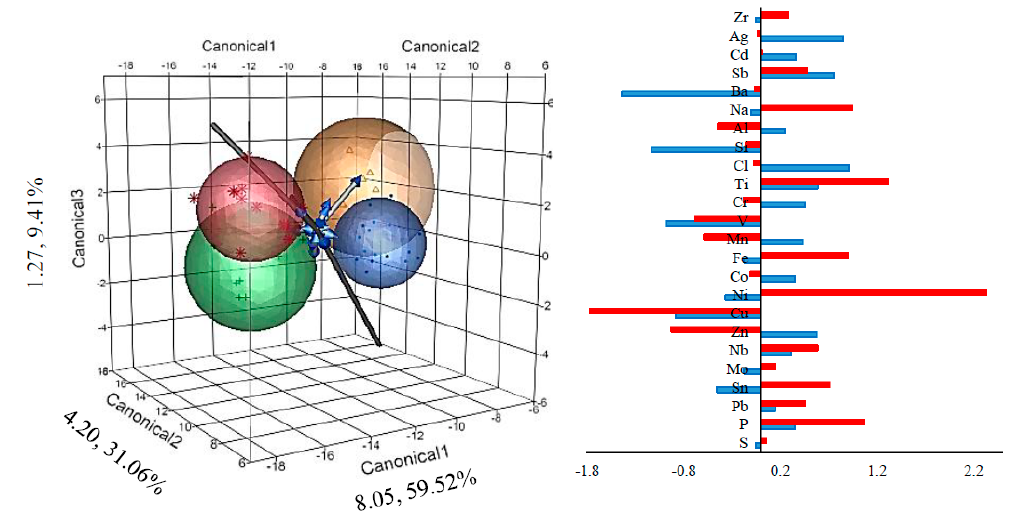
Figure 3. (Left) 3D canonical score plot obtained for the elemental analysis using SL-CDA. Values next to the canonical function represent the eigenvalue and the corresponding % of variation explained. Markers represent the same data presented in the previous figure. (Right) Canonical scores for each element, blue bars correspond to the canonical scores obtained for the first canonical function, whilst the red bars represent the scores obtained for the second canonical function .